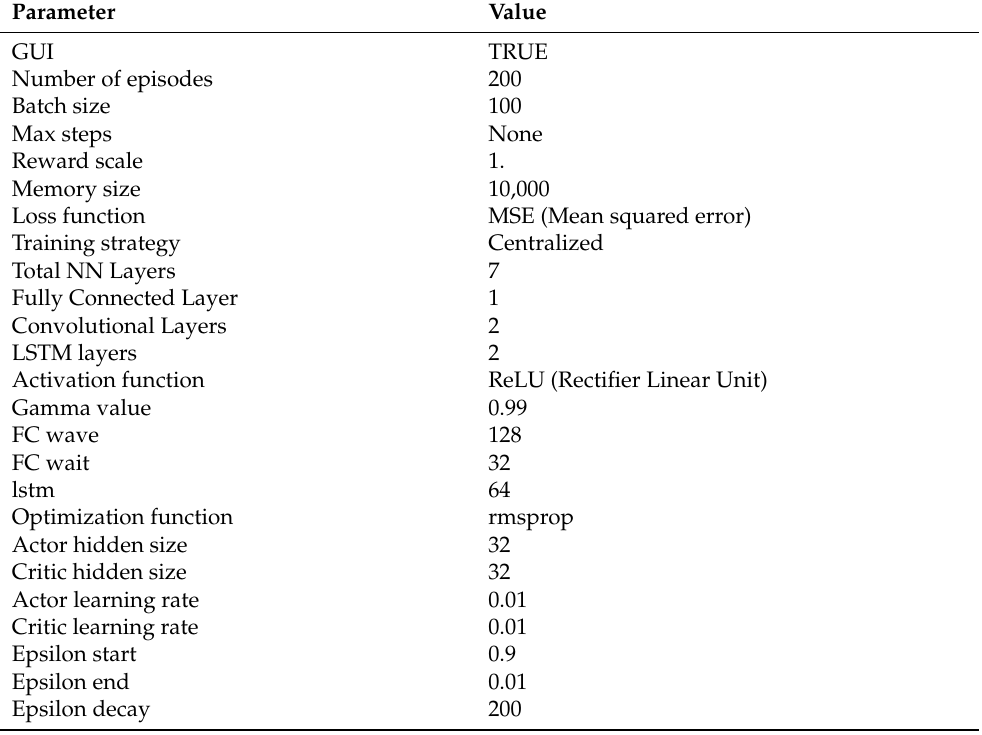
Table 2. Training